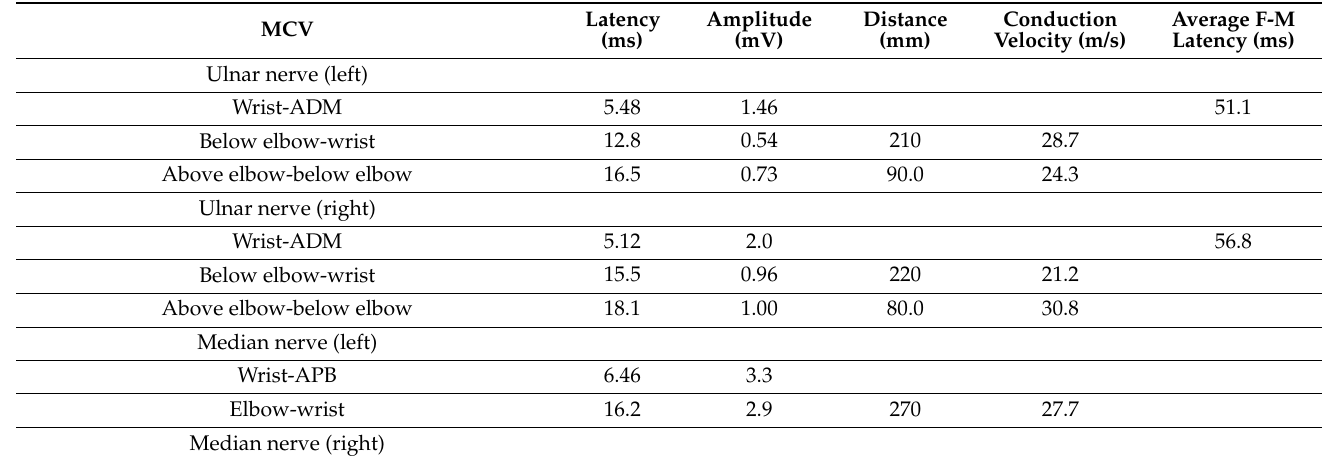
Figure 1. Reactivity to NF 155 and NF186 by CBA Anti-NF 155 IgG4 antibodies detected in the patient’s serum ( A ) (titer 1:1000) and CSF ( B ) (titer 1:100) using CBA method. Anti-NF186 IgG4 antibodies detected in the patient’s serum ( C ) (titer 1:100) and CSF ( D ) (titer 1:100) using CBA method. CBA: cell-based assay; CSF: cerebrospinal fluid; Ig: immunoglobulin; NF: neurofascin. Table 1. The nerve conduction velocity (NCV) features of the patient.